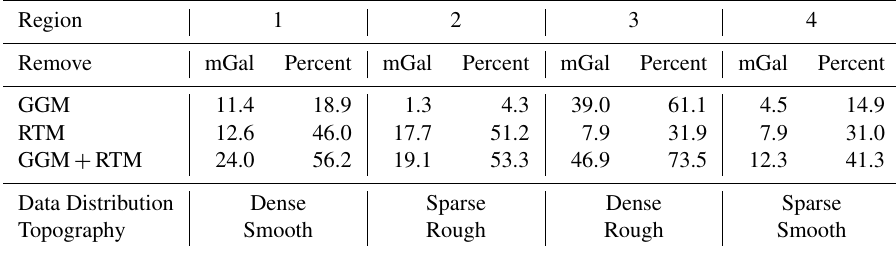
Table 5. Parameters of the empirical and analytical COVs in each region. Region 1 2 3 4 Sample interval